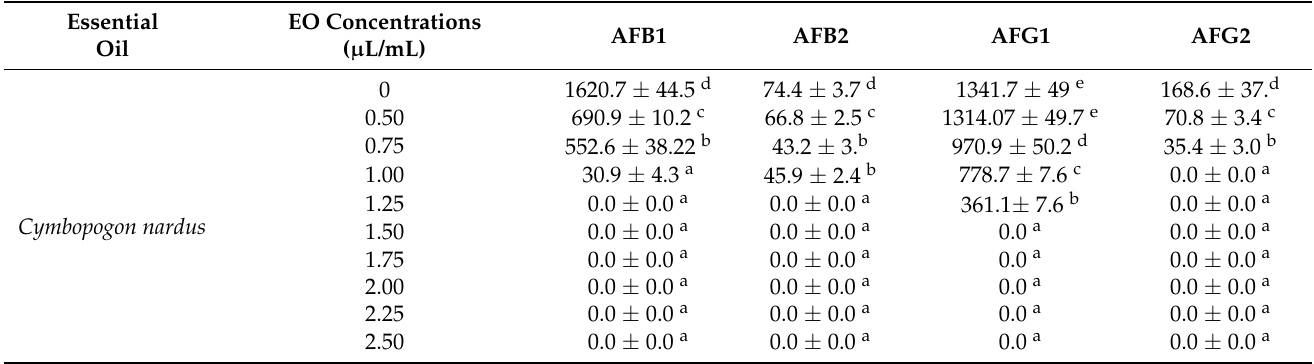
Table 8. Effect of C. nardus essential oil on aflatoxin production ( µ g/kg) after 7 days exposure to different concentrations.